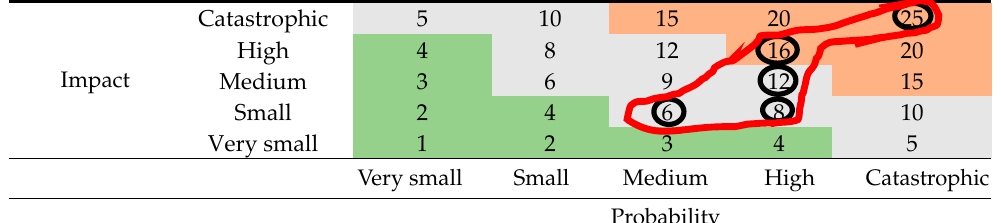
assuming risk. Figure 3 presents a graphical map of the risk levels in supply chains. The structure of the chart reflects the results of the analysis carried out on the basis of the risk maps. All positions requiring a risk response strategy are placed inside the dangerous ranges.